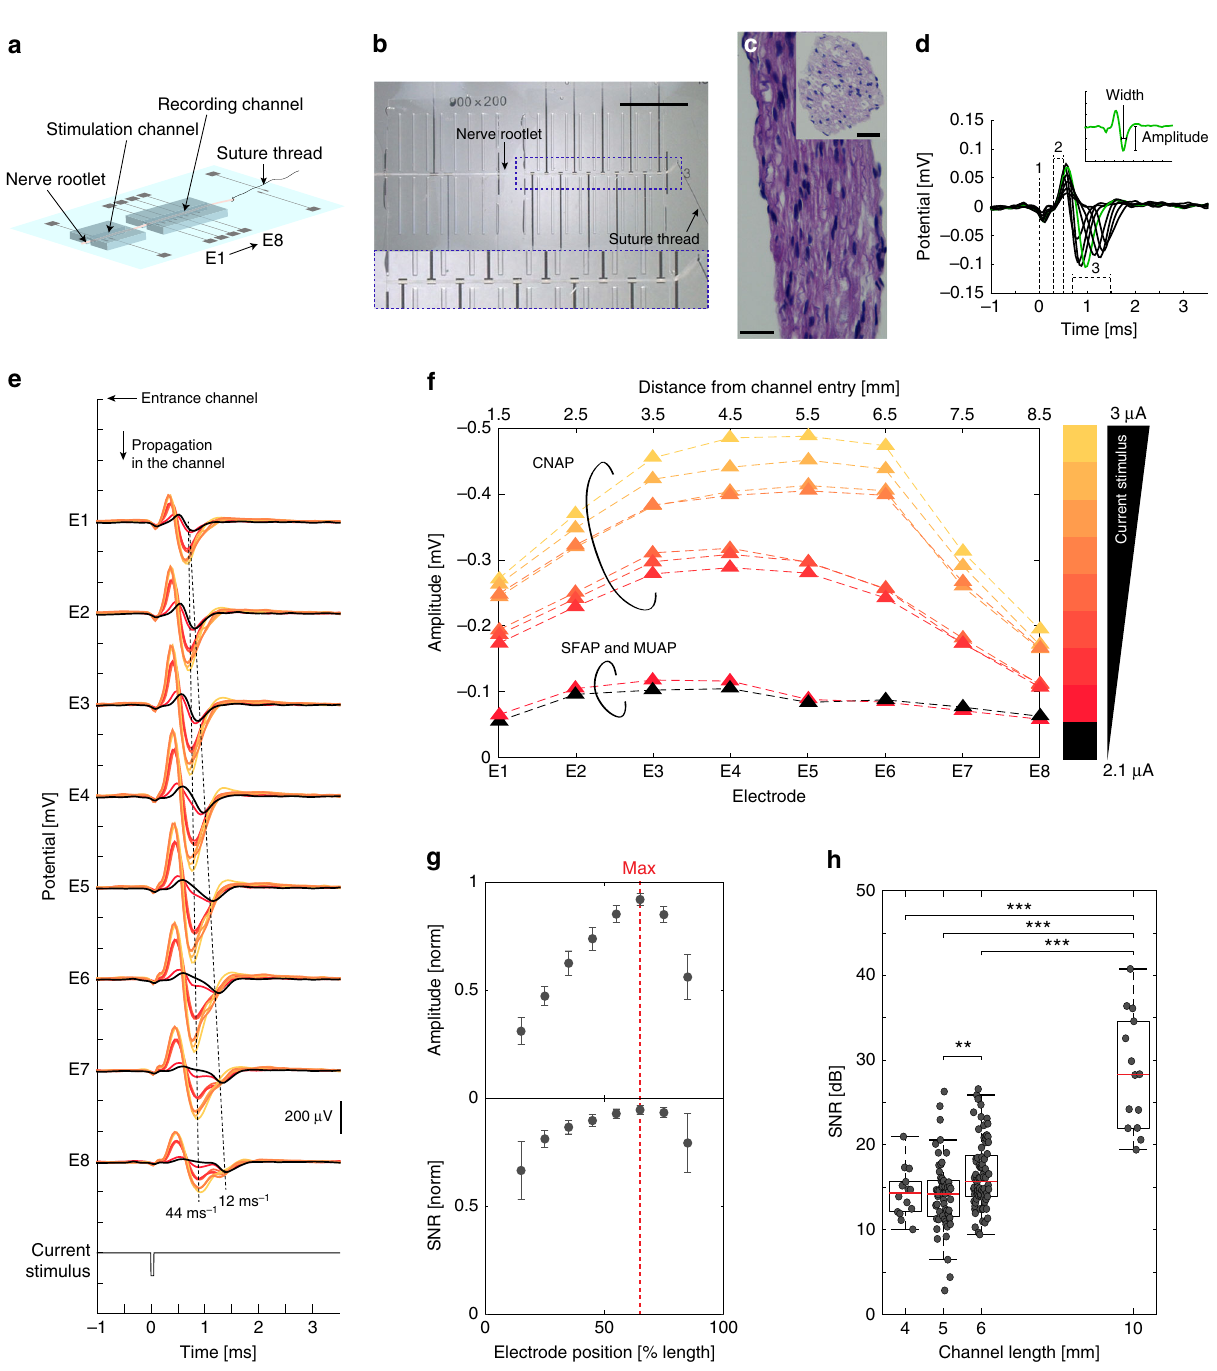
Fig. 1 Nerve-on-a-chip design and recording capabilities. a Schematic of the nerve-on-a-chip platform. b Photographs of a teased nerve rootlet (100 μ m diameter) inserted in the platform. Recording and stimulation electrodes are 100 × 300 μ m 2 and 100 × 600 μ m 2 , respectively; electrode pitch is 1 mm; stimulation and recording microchannels are 8 and 10 mm long respectively. One end of the rootlet is tied with a suture thread then pulled inside the channel, as depicted in a . Scale bar: 5 mm. c Hematoxylin staining of cross and longitudinal section of a rootlet. Scale bar: 25 µ m. d Superimposed recording of one SFAP along eight electrodes, highlighting stimulation artifact (label #1, simultaneous on all electrodes), onset artifact provoked by SFAP entry in the recording microchannel (label #2, simultaneous on all electrodes), and biological signals (label #3, depolarization wave, delayed between each electrode) (stimulation current: 2.1 µ A, phase: 50 µ s). Insert: SFAP amplitude is measured from baseline and SFAP width is measured at half amplitude. e Representative nerve signals recorded along one rootlet by all eight electrodes with increasing stimulation current (increment: 0.1 µ A). Recorded signals are either SFAP, MUAP, or CAP. Color from black to yellow: stimulation current from 2.1 to 3 μ A (increment: 0.1 μ A, phase: 50 µ s). f Maximal amplitude of neural signals along the channel. Increasing current pulses trigger SFAP, MUAP, then CAP (color code as in e and f ). g Average of normalized SFAP amplitude and SNR along all eight electrodes. Maximal SNR and amplitude is reached at 2/3 of the microchannel length (red dashed line). Error bar: pooled standard error ( n = 14 SFAP, each repeated 10 × ). h Boxplots of SFAP SNR recorded in microchannel. SNR is positively correlated with velocity (Supplementary Fig. 3); resulting SNR range increases with microchannel length. Pair comparison was done using Kruskal – Wallis test ( α = 0.05) with Bonferroni correction (4 mm: n = 22, 5 mm: n = 75, 6 mm, n = 86 10 mm: n = 16). Signi fi cance: *** p < 0.001, ** p <